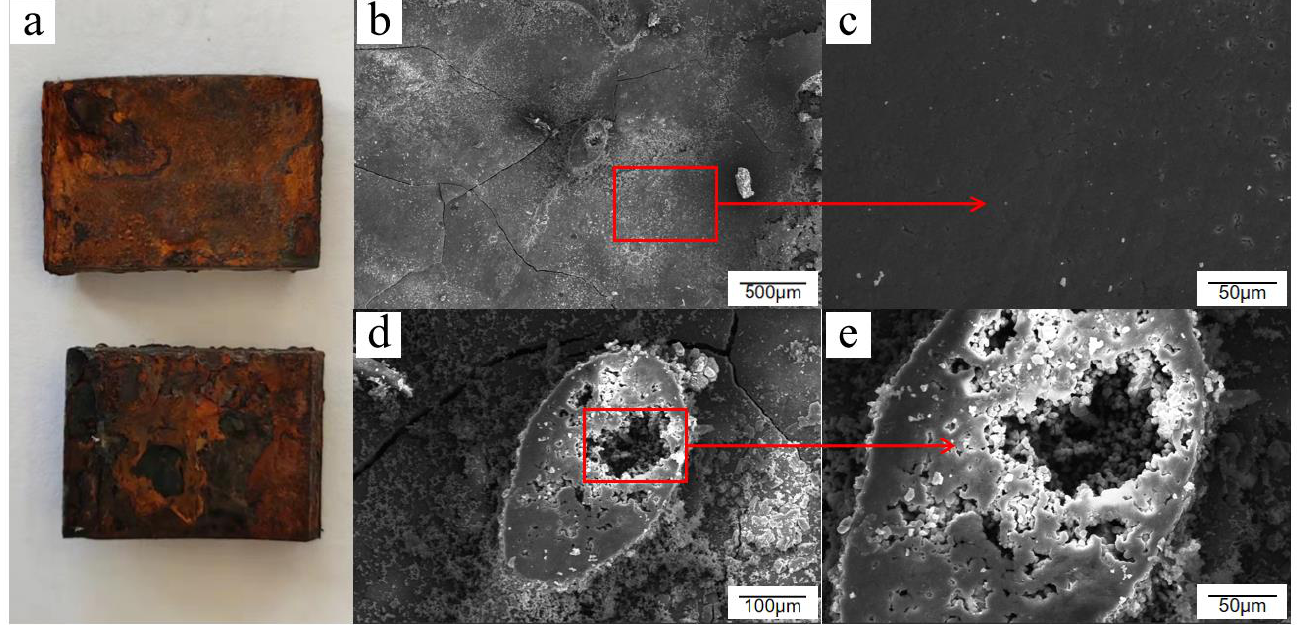
Figure 7. Macroscopic and microscopic morphology of Q235 low-carbon steel after 12 days of exposure in the cyclic salt spray accelerated corrosion test: ( a ) macroscopic appearance, ( b ) overall appearance, ( c ) flat rust layer, ( d ) rust cracked protrusion, and ( e ) internal corrosion growth.